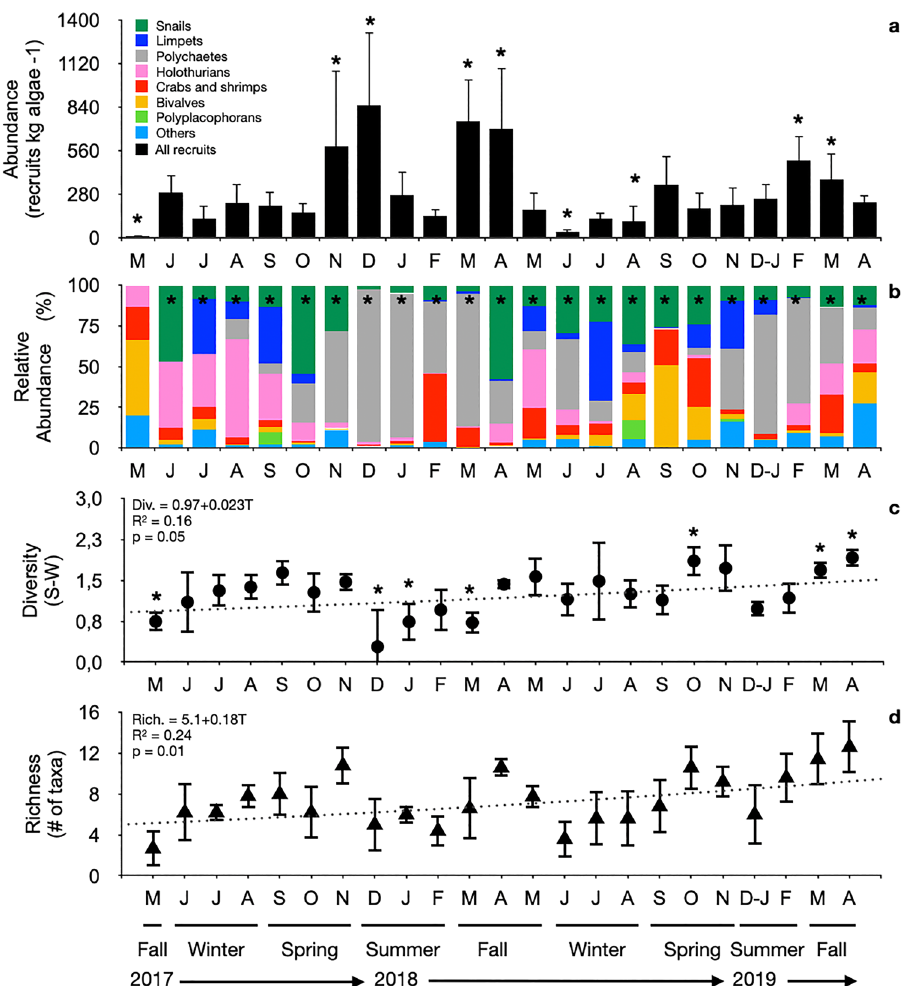
Figure 2. Monthly recruitment abundance (total abundance of recruits; ( a ), assemblage composition (number of recruits per taxa; ( b ), diversity (Shannon–Wiener Index S-W; ( c ), and richness (number of species/taxa; ( d ) (per kg of algae) at the study site. Note: averages and standard deviations are represented by columns/symbols and error bars respectively; color bars represent relative frequency per taxa (%); the dotted lines represent the linear trends in recruitment from the regression analysis; and significant monthly differences according to ANOVAs and PERMANOVAs are highlighted